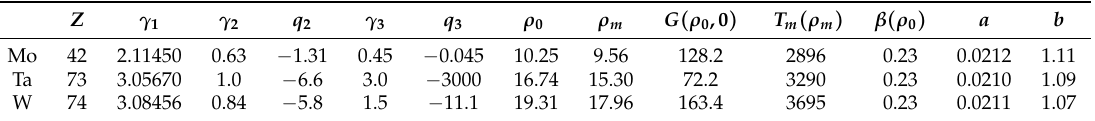
Table 1. Numerical values of the parameters for the thermoelasticity model, Equation (41) (in the corresponding units). In Equation (41) G ( ρ ,0 ) and T m ( ρ ) are given by Equations (13) and (14), respectively. The last three columns of the table apply to the bcc phases of the three transition metals for which β = β ( ρ ) = β ( ρ 0 ) + a ( ρ − ρ 0 ) b .